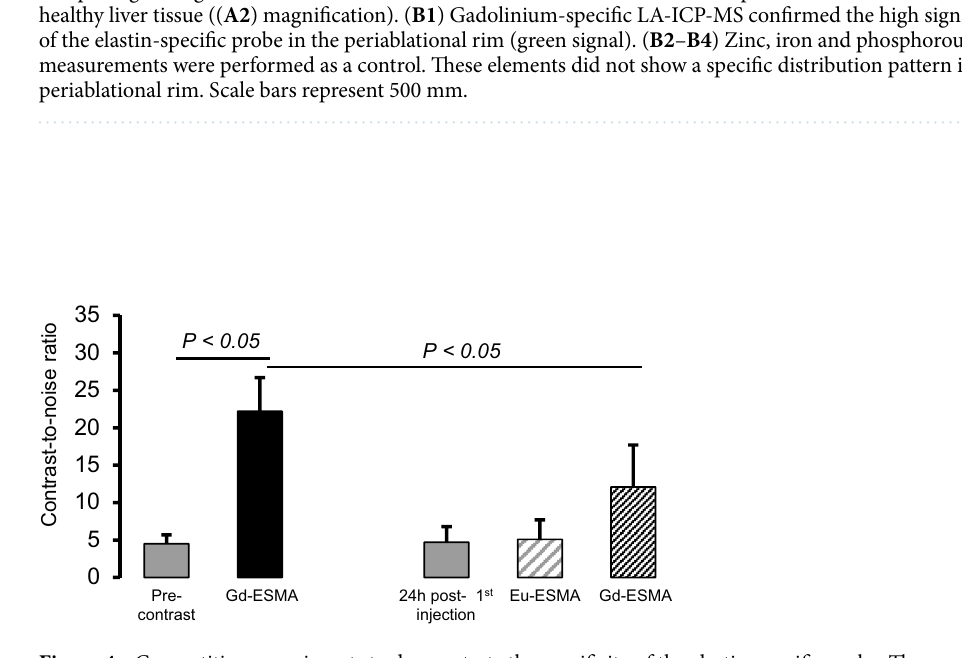
Figure 4. Competition experiments to demonstrate the specificity of the elastin-specific probe. The specific binding of the elastin-probe was confirmed by in vivo competition experiments in three animals three weeks after RF ablation. Following the injection of a tenfold higher dose of the non-paramagnetic europium-labeled elastin-specific-probe, a significant decrease of CNR was observed, compared to the administration of the gadolinium-labeled elastin-specific contrast agent alone indicating the specific binding of the